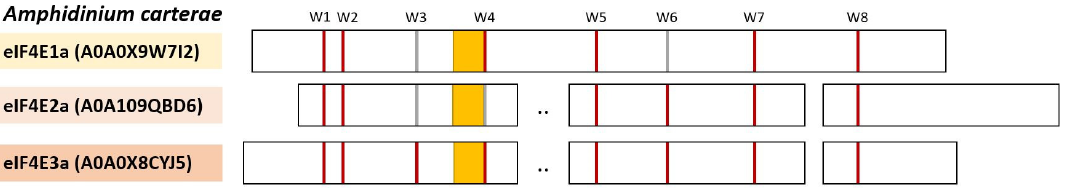
Figure 5. Scheme representing the core of dinoflagellate eIF4E1a, eIF4E2a, and eIF4E3a from Amphidinium carterae (accession numbers in brackets) including the eight conserved tryptophane residues W1 to W8 (labelled in red), and substitutions of W3, W4, and W6 for Y or F (labelled in grey). Highlighted in yellow is also the conserved helix-forming motif STVxxF next to W4.